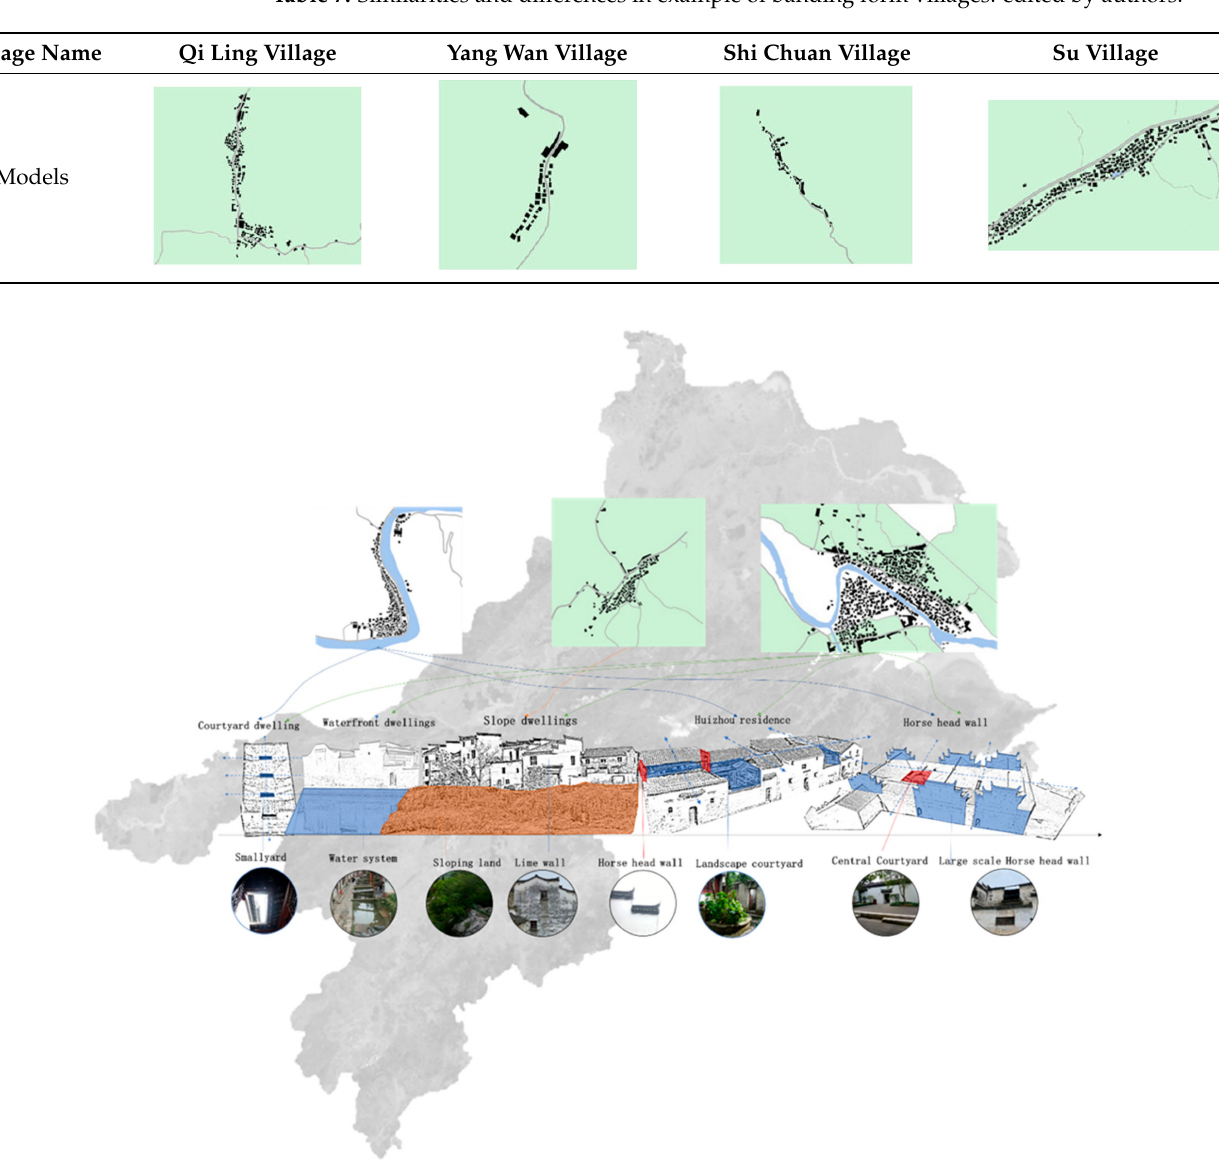
Figure 11. Jiangnan traditional village internal logical relationship: edited by